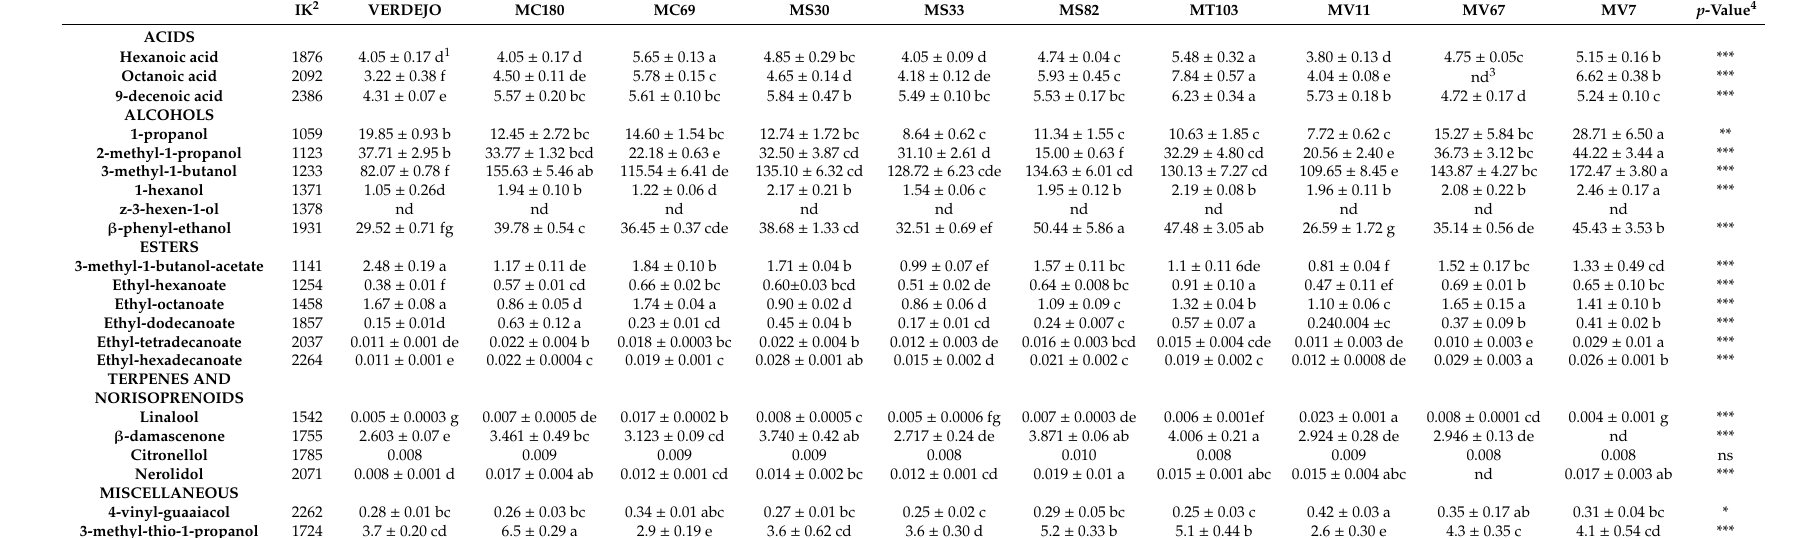
Table 3. Individual aromatic concentrations in wines (expressed as mgL − 1 ) at the end of alcoholic fermentation in